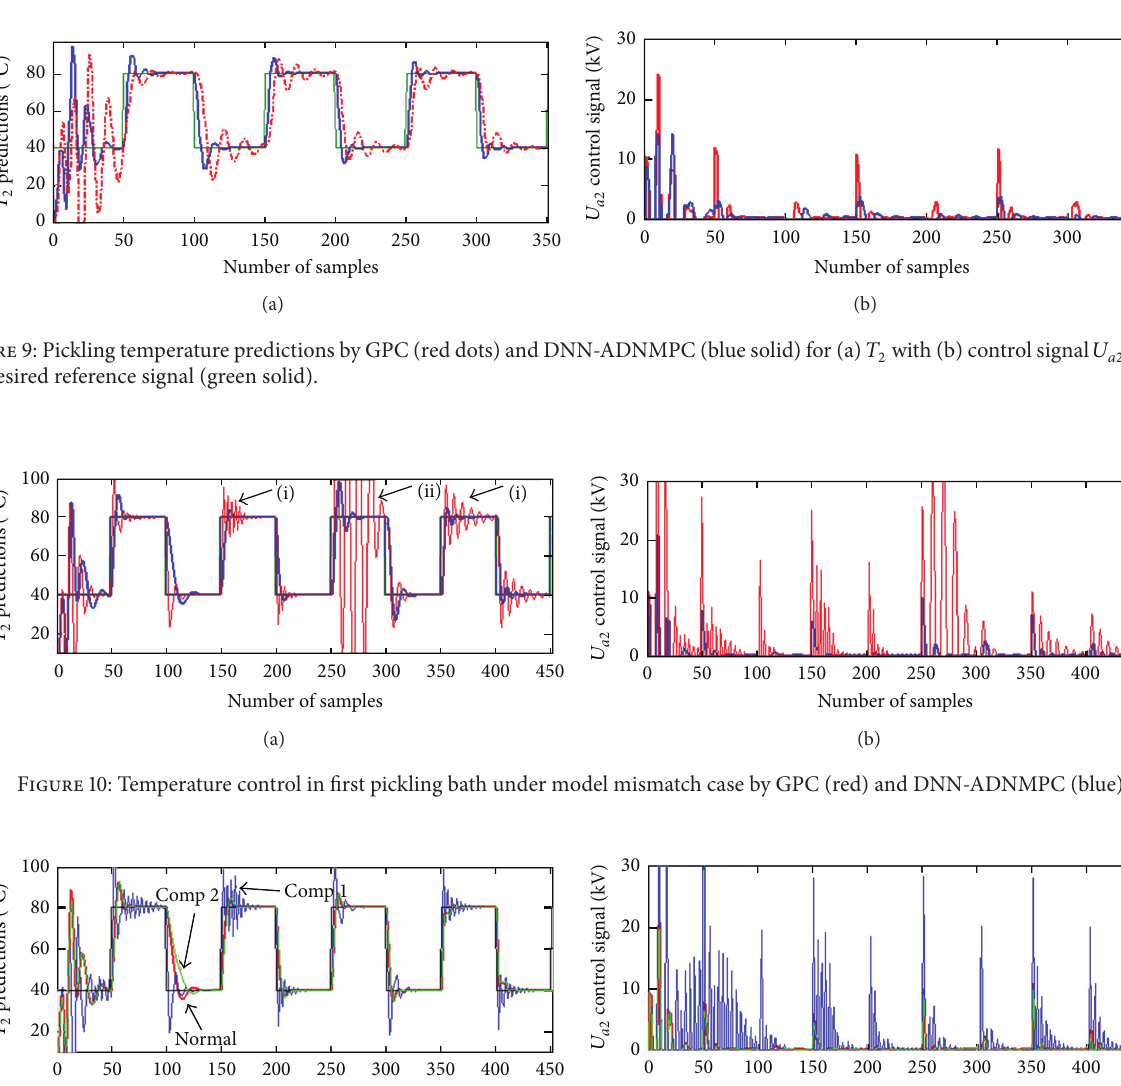
pickling process is 90 seconds while the average